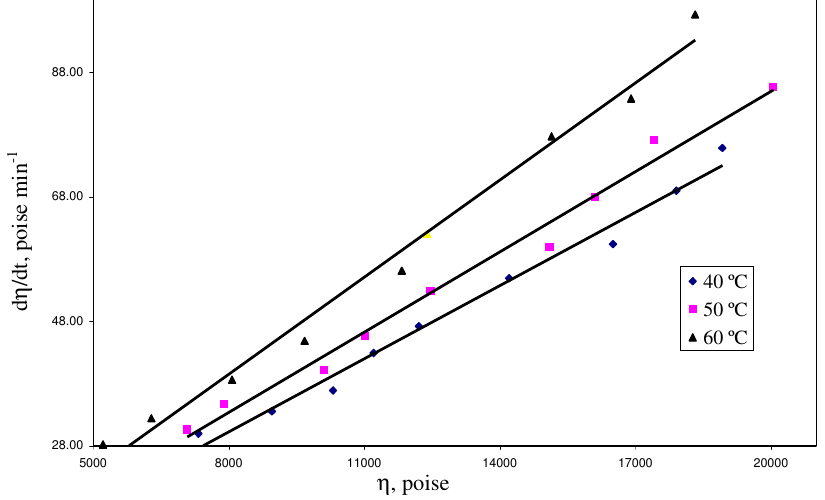
Figure 1. Plots of viscosity ( η ) vs . time (t) of the propellant slurry at three different temperatures.